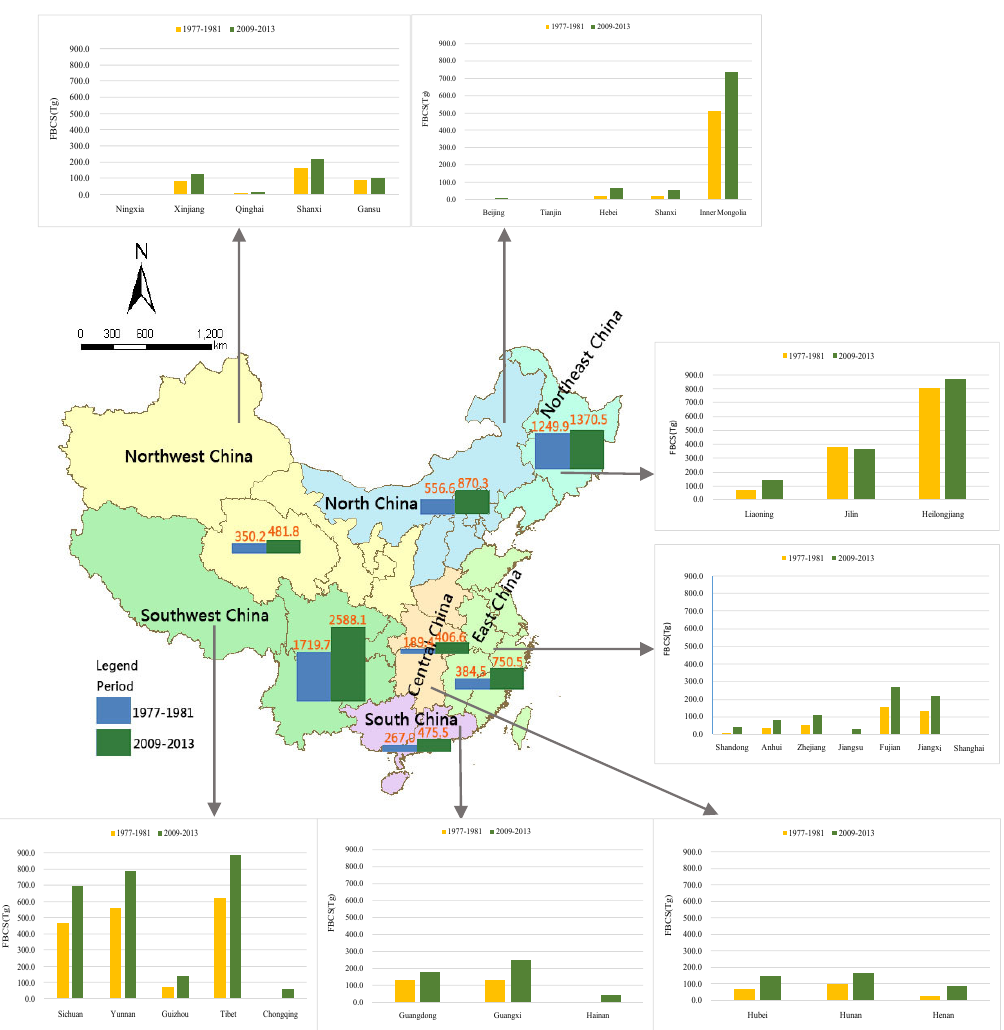
Figure 1. Spatiotemporal distribution of China’s forest biomass carbon storage (FBCS) comparing two five-year periods (1977–1981 and 2009–2013 inclusive). Blue and green bars displayed within the map itself compare regional totals for the two periods, with individual contributions from provinces within the regions shown in the individual barcharts.